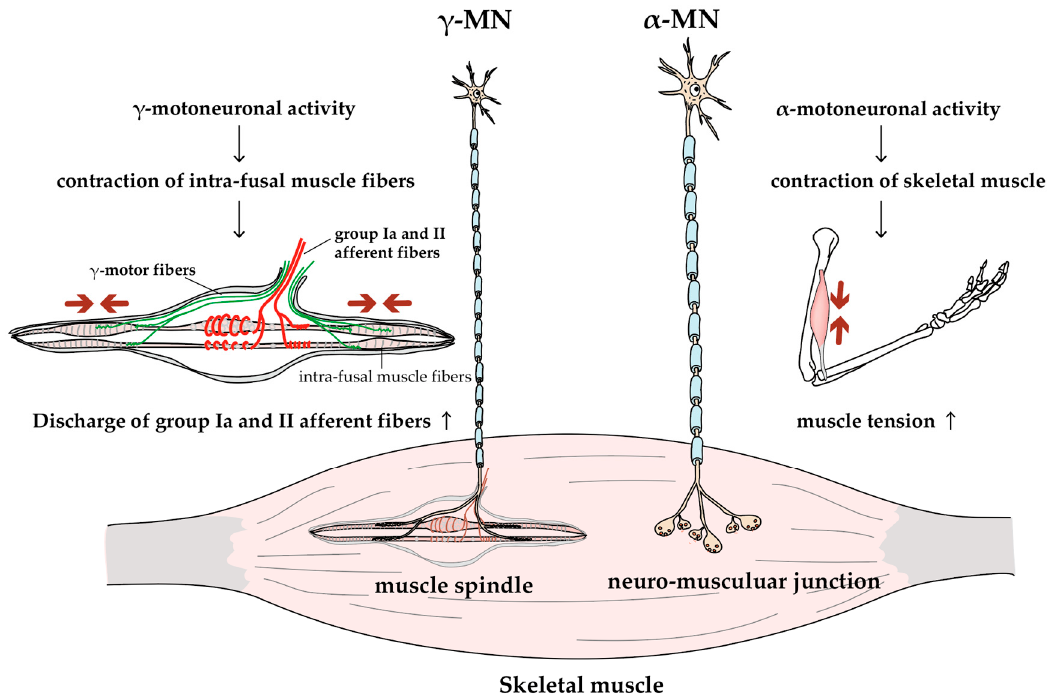
Figure 2. Function of alpha and gamma MNs. MNs can be divided into two groups: larger α -MNs and smaller γ -MNs. α -MNs innervate skeletal muscles, and their activity generates muscle tension and joint movements; γ -MNs innervate intrafusal fibers of muscle spindles, and their activity increases the group Ia and II afferent discharges (i.e., increases the sensitivity of muscle spindles [38]).